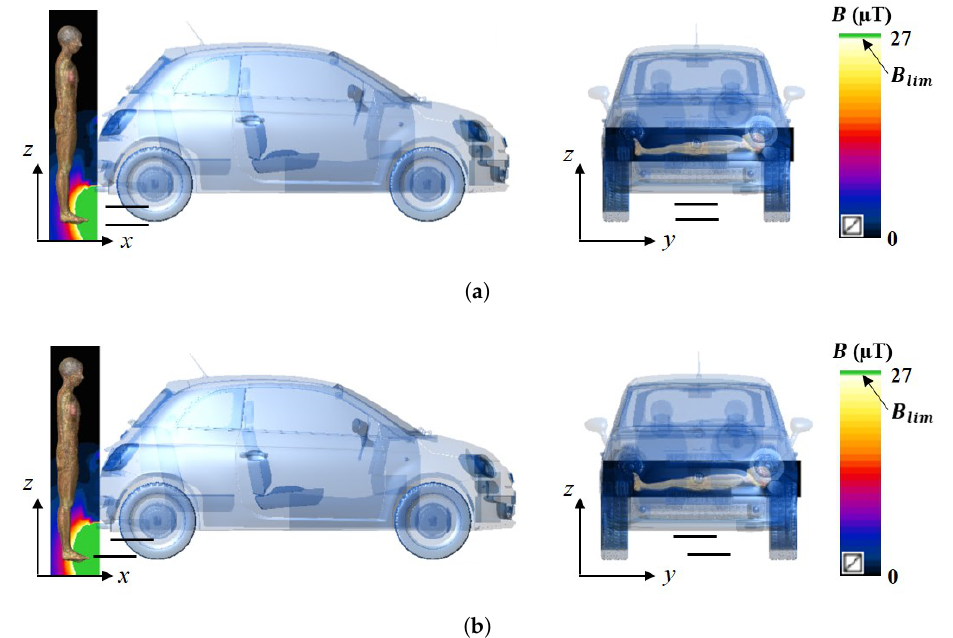
Figure 5. B -field distributions for exposure scenario #3 in the aligned ( a ) and misaligned ( b ) coil positions. B lim is the RL = 27 µ T (the green area is the portion where the RL is